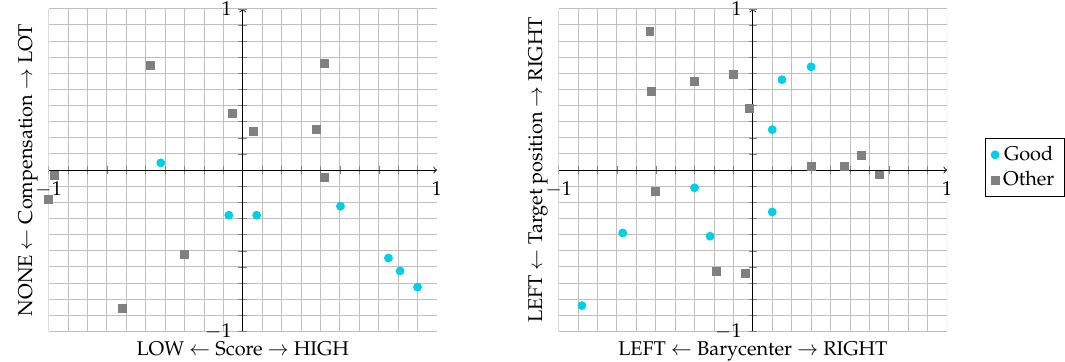
Figure 4. Plot of Score–Compensation and Barycenter–Target position features in OwlNest game. Data were labelled as “Good” or “Other” by the therapist according to patients’